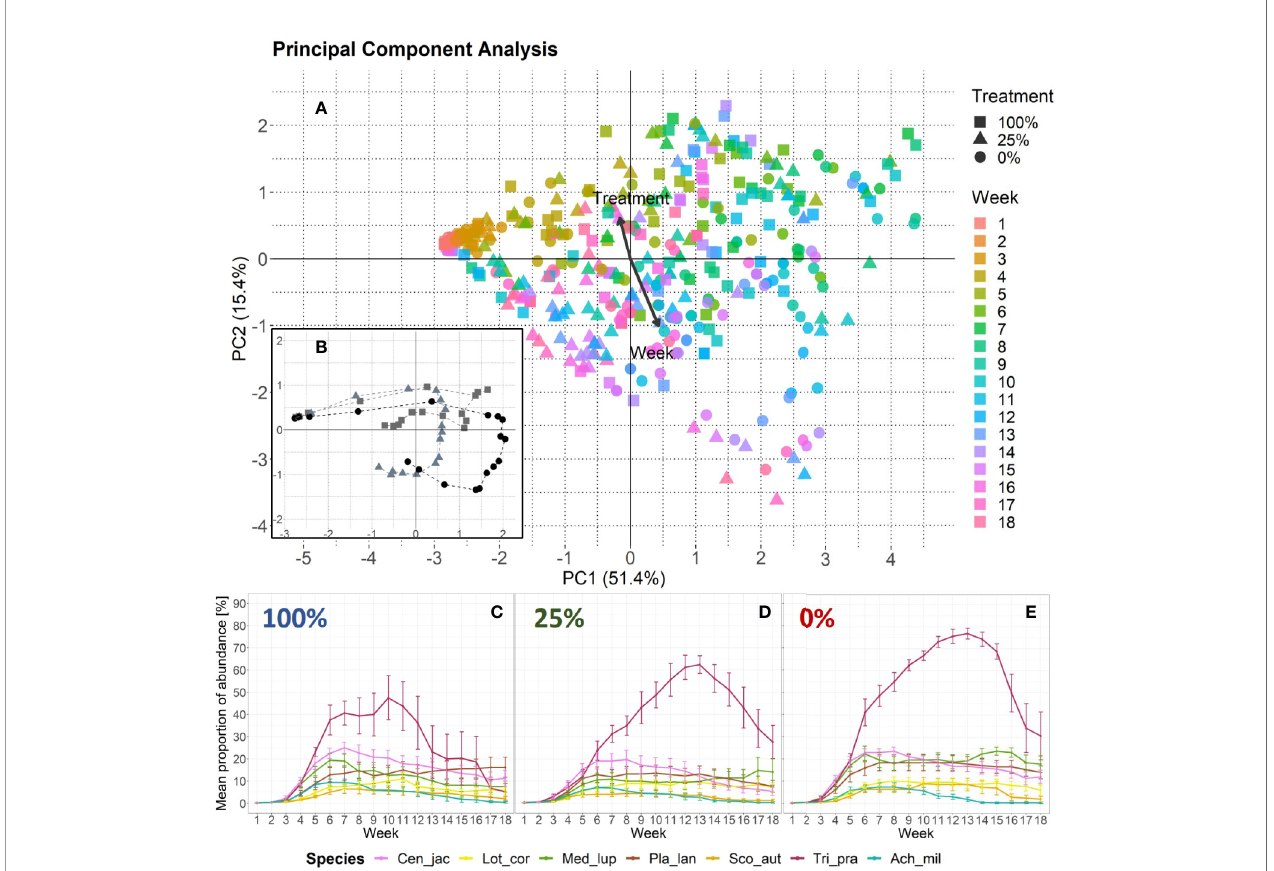
FIGURE 2 | Changes in plant species abundance over time per treatment. (A) Principal component analysis based on species abundance data. One data point represents one EcoUnit of the iDiv Ecotron observed in 1 week (n = 431). The community development over time (18 weeks) is indicated by a color gradient representing the week. Eigenvalues are given in percent and represent the explained variance according to the axes. The treatments are represented by fi lled symbols (square = 100%, triangle = 25%, circle = 0%). Variables week and treatment are post-hoc correlated (p < 0.001). Arrows are enlarged in scale by the factor two to fi t the scale of the plot. Their lengths show differences in explained variance relative to each other. (B) PCA-centroids per week and treatment. The dashed lines connect the symbols that represent the plant community abundance development over time. (C , D) Plant species-speci fi c changes in abundance over time as given by mean proportion of percentage values with standard error. Each invertebrate treatment is represented by a panel: (C) 100%-treatment, (D) 25%-treatment, and (E) 0%-treatment. The seven plant species are color-coded. Species abbreviations are listed in Table 1